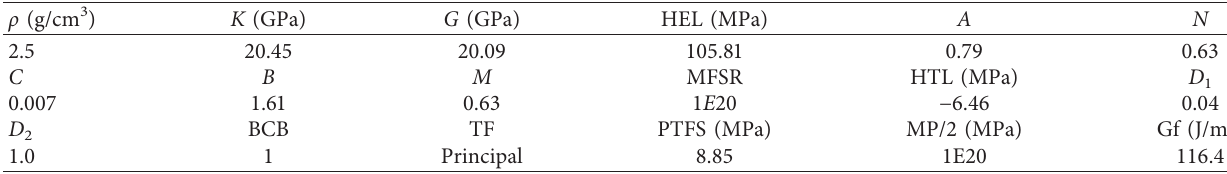
Table 3: The JH-2 model of parameters of the concrete.